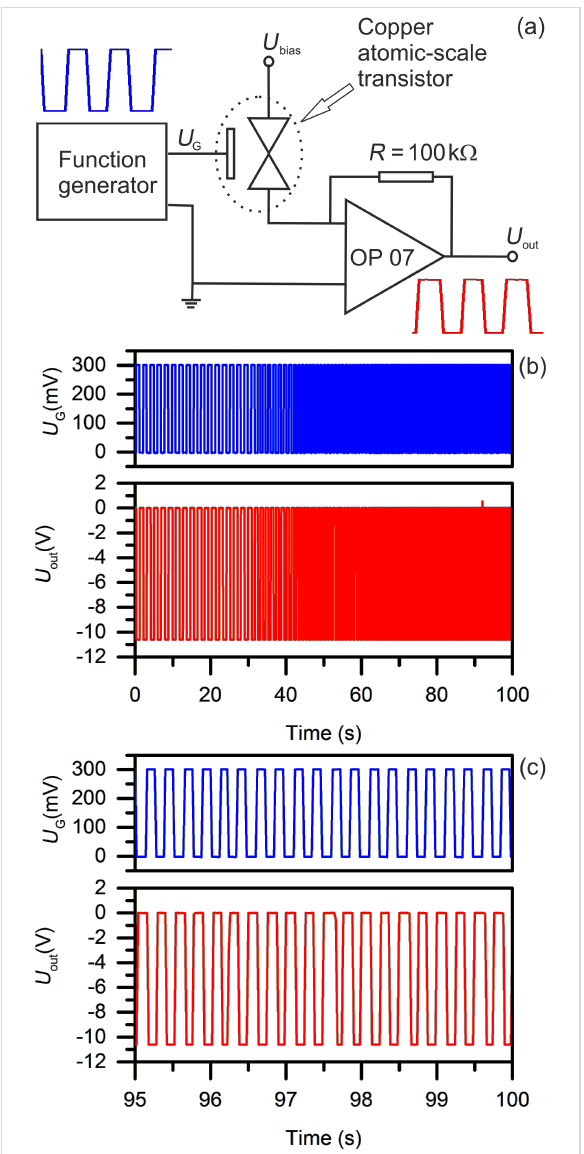
Figure 5: The operation of a copper atomic-scale transistor driven by a function generator. (a) Schematic diagram of the function-generator- driven copper atomic-scale transistor connected to a current-to-voltage converter circuit. (b) Rectangular wave signal from the function gener- ator (blue) switched between 0 and 300 mV with frequencies from 0.5 Hz to 4 Hz. The output U out (red), following the signal from the function generator, is driven between 0 and − 10.6 V. (c) Zoom-in on the switching sequence from 95 to 100 s.